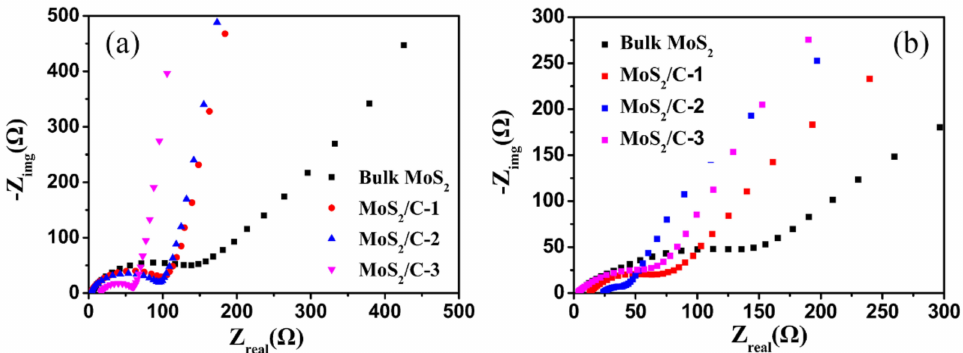
Figure 8. Electrochemical impedance spectra of the bulk MoS 2 and MoS 2 /C electrodes before cycling ( a ) and after cycling 50 cycles ( b ) at a current density of 100